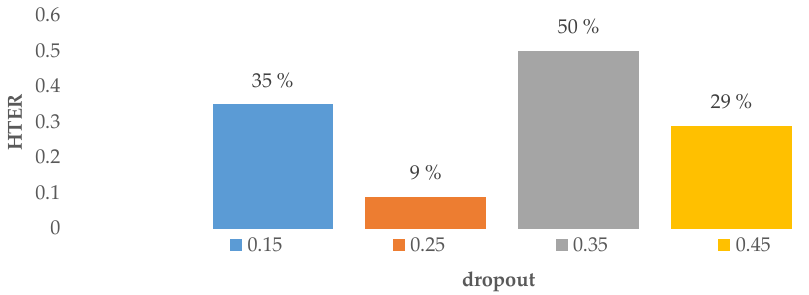
Figure 5. Impact of the input image size in the custom model in terms of HTER (the lower the bet- ter).